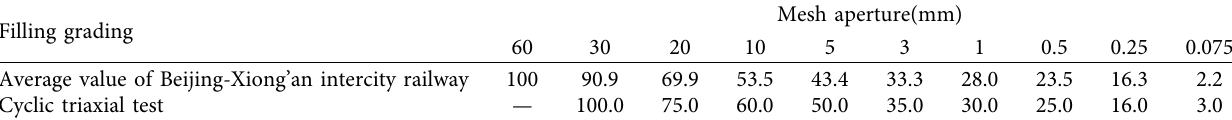
Table 1: Filling grading of cyclic triaxial test.